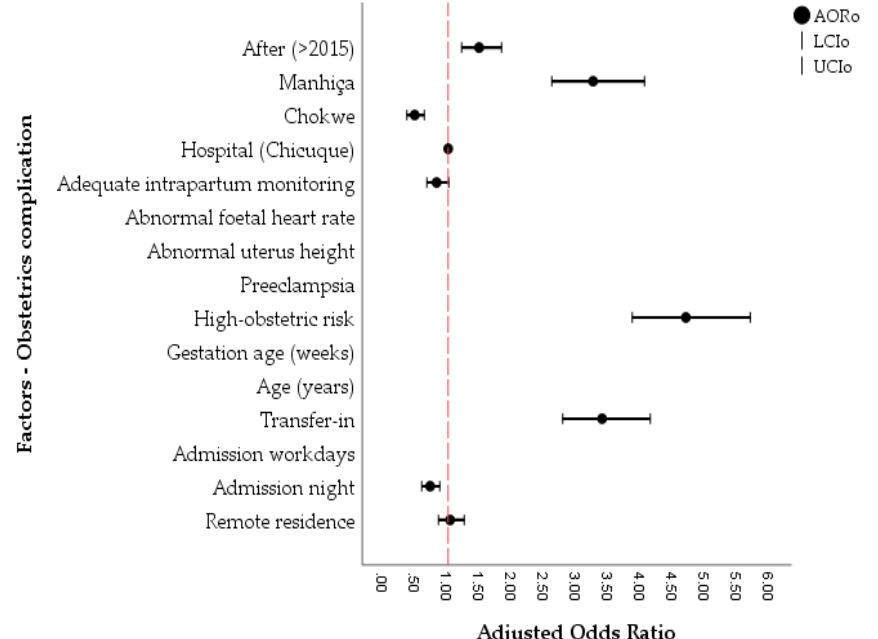
Figure A2. Factors Associated with First Caesarean.